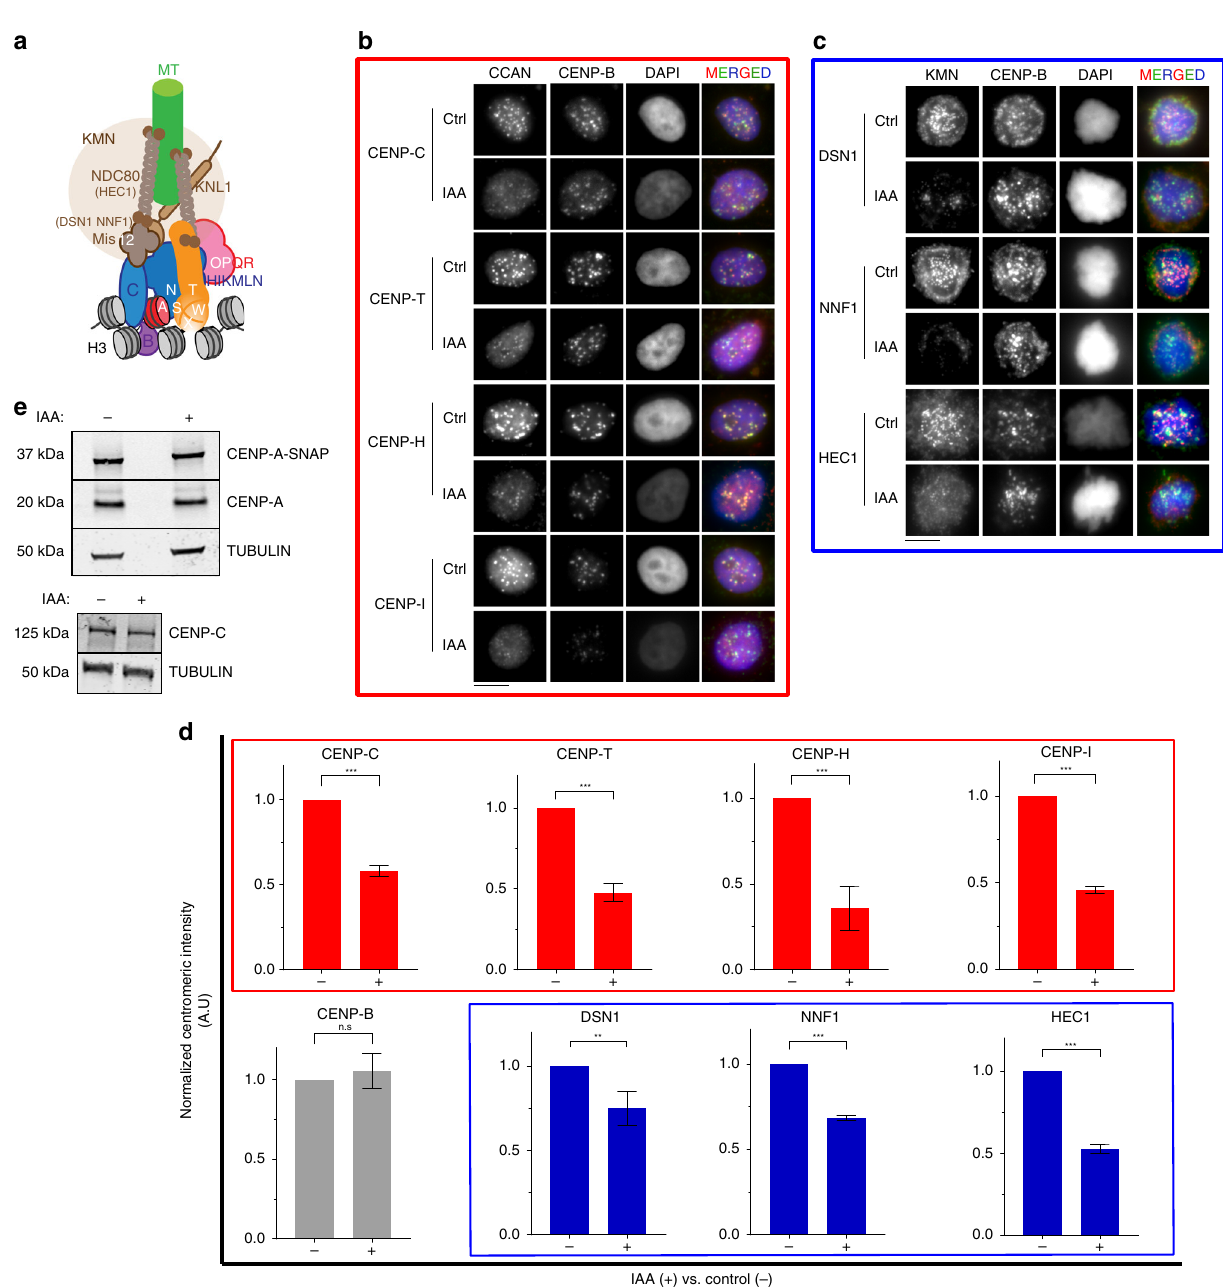
Fig. 5 SENP6 is required for maintaining the integrity of the CCAN independent of proteolysis. a Schematic representing the architecture and interactions of different protein complexes in the human centromere and kinetochore. b Centromeric levels of different CCAN proteins following auxin- mediated depletion of SENP6 (24 h). Cells were counterstained with CENP-B to mark centromeres. Bars, 10 µ m. c Centromeric levels of KMN (KNL1- MIS12-NDC80) members following auxin-mediated depletion of SENP6. Bars, 10 µ m. d Automated centromere recognition and quanti fi cation of b and c . Fluorescence intensities of indicated proteins were normalized to the mean of the control ‘ no auxin ’ condition in each experiment and plotted as a bar graph for auxin treated ‘ + ’ or no auxin ‘ − ‘ condition. Three replicate experiments were performed. Bars represent SEM. Parametric two-tailed Student ’ s t test were performed to calculate statistical signi fi cance. ** p < 0.01, *** p < 0.001. e Immunoblot showing the total levels of CENP-A and CENP-C proteins following 48 h treatment with auxin to deplete AID-SENP6. Extracts from control ‘ − ‘ or auxin treated ‘ + ’ cells were separated by SDS-PAGE and immunoblotted with anti-CENP-A (detecting both SNAP tagged and endogenous CENP-A) or anti-CENP-C antibody. Tubulin was used as loading control. Source data are provided as a Source Data fi